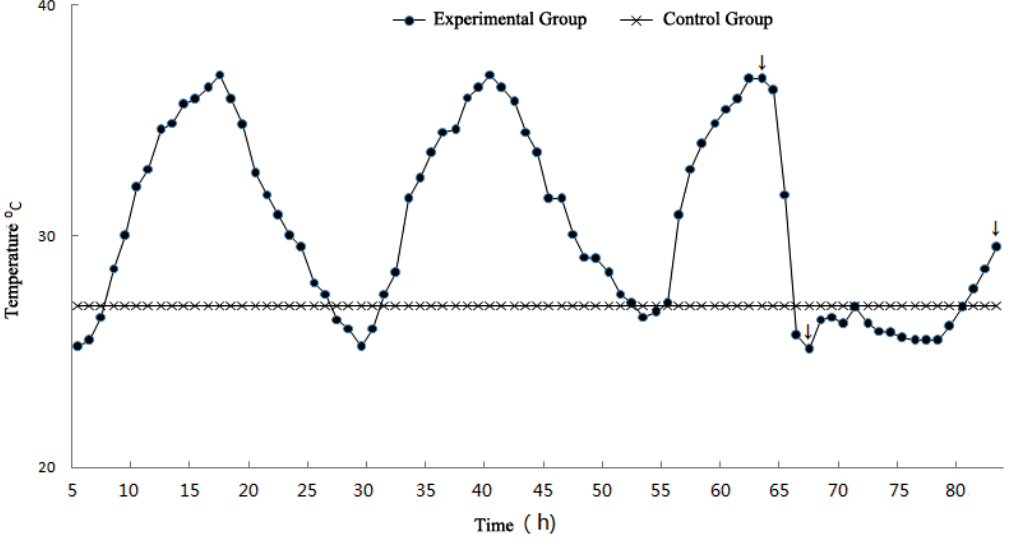
Figure 1. Experiment temperature curve (arrows represent sampling time